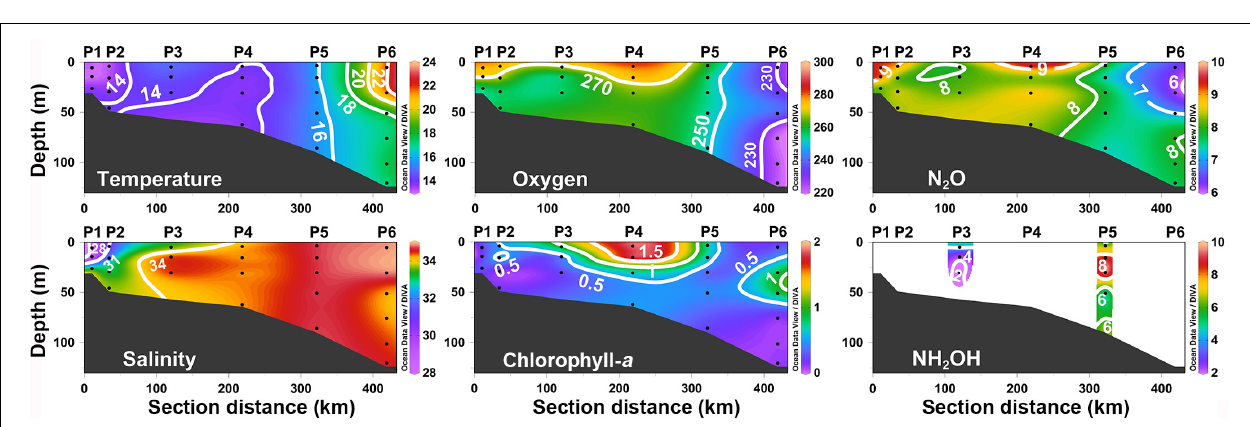
FIGURE 4 | The vertical distributions of temperature ( ◦ C), salinity (psu), dissolved oxygen ( µ mol L − 1 ), chlorophyll- a ( µ g L − 1 ), N 2 O (nmol L − 1 ), and NH 2 OH (nmol L − 1 ) along section D.